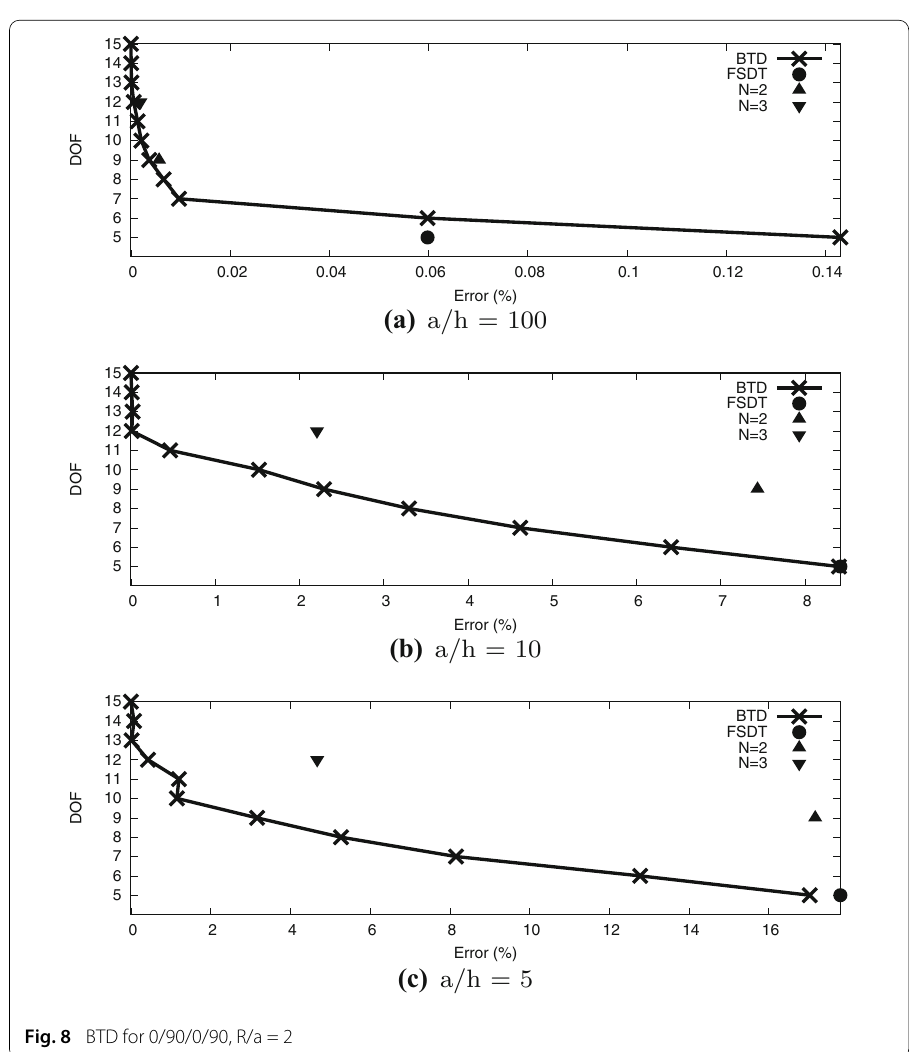
Fig. 8 BTD for 0/90/0/90, R/a = 2